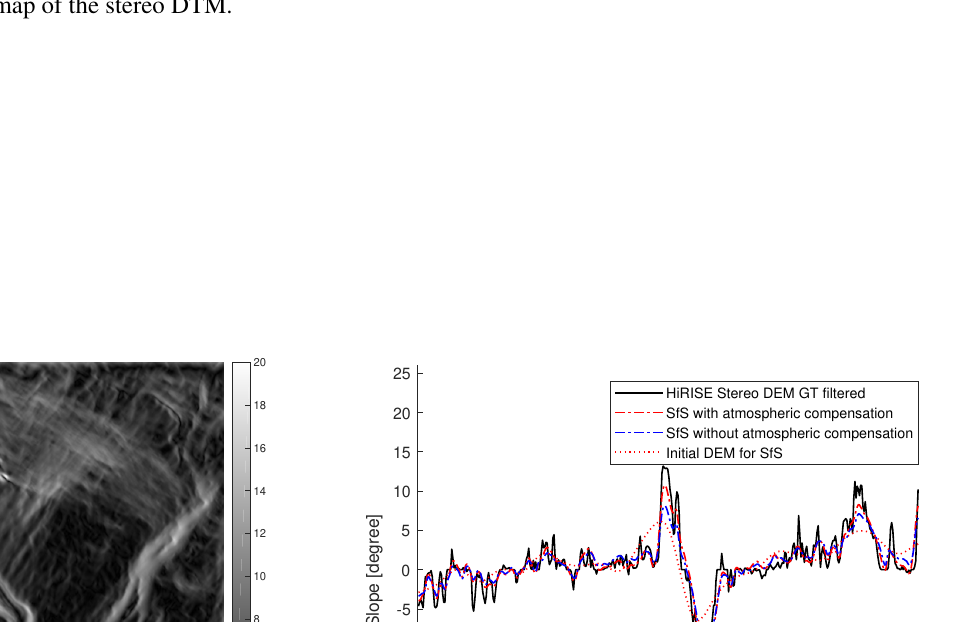
Figure 7. Height profile produced with the different methods.